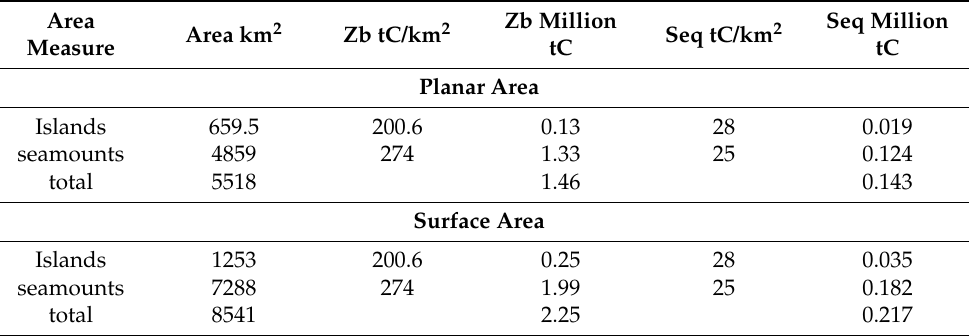
Table 5. Seabed area <1000 m depth and zoobenthic carbon around the Tristan da Cunha archipelago. Planar area is the 2-D estimate and so an underestimate of true surface area, which takes account of topography. The columns are from left to right; localities, area, zoobenthic stored carbon in tonnes per km 2 (ZbC t/km 2 ), total zoobenthic stored carbon in million tonnes (ZbC Mt), zoobenthic carbon expected to be sequestered in tonnes per km 2 (Seq t/km 2 ), total zoobenthic carbon expected to be sequestered in million tonnes (Seq million t).